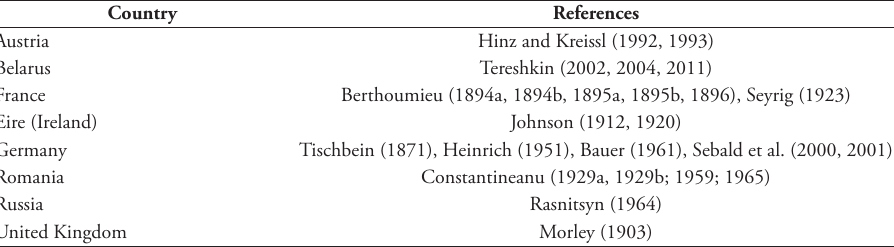
Table 1. Major compilatory works on ichneumonid hibernation by